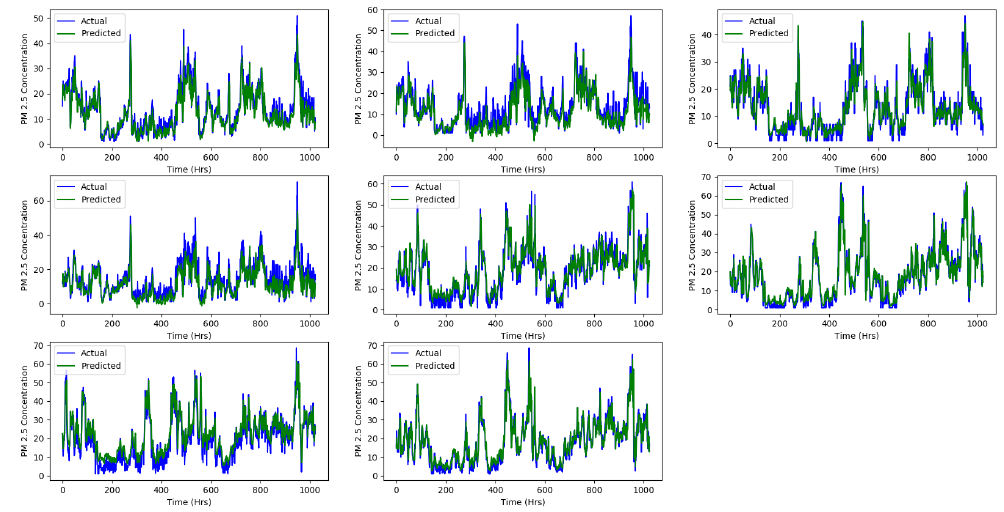
Figure 10. The predicted results of LSTM.